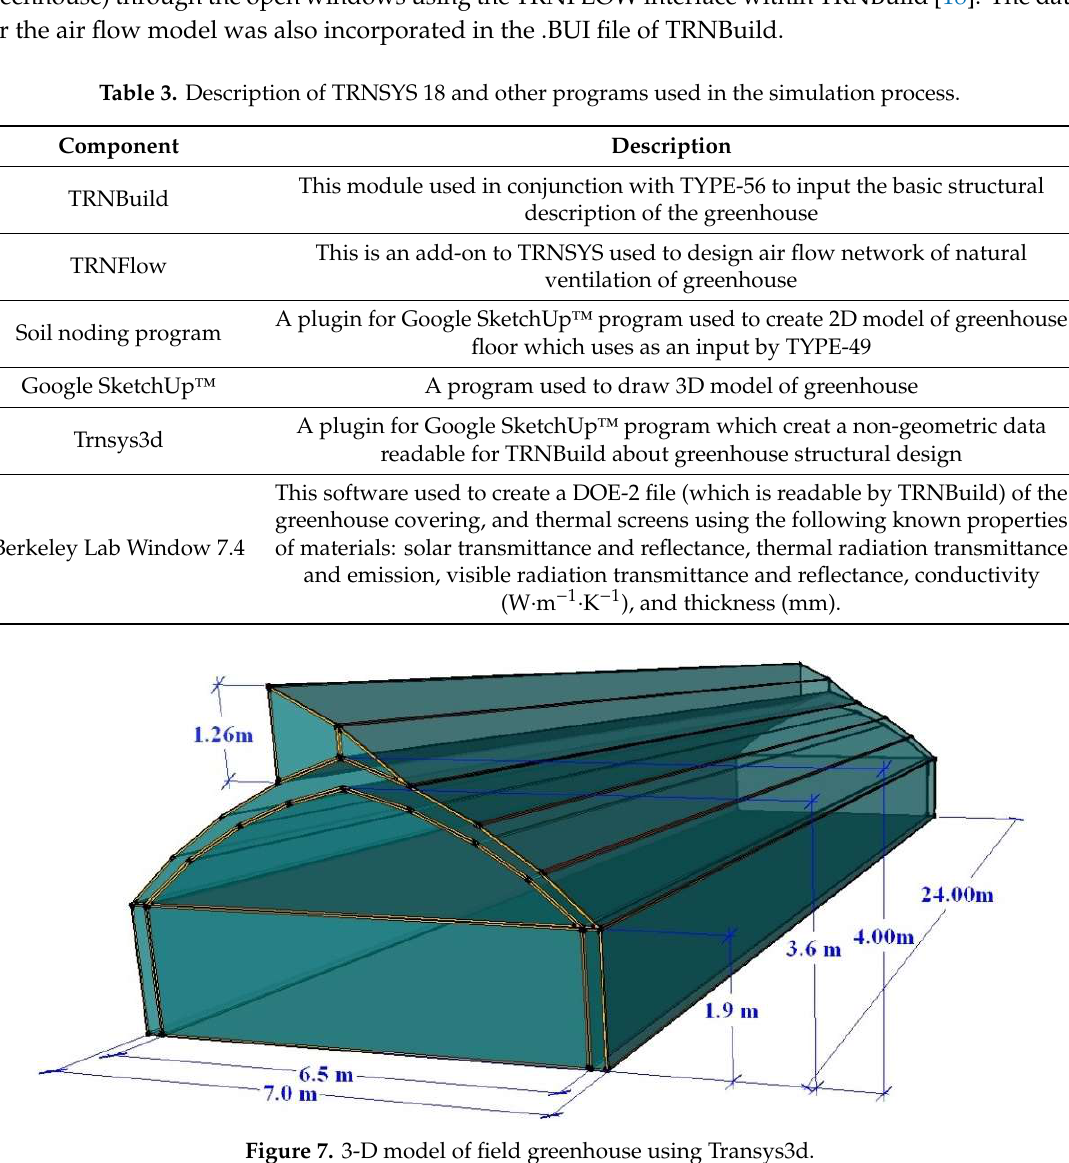
Figure 7. 3-D model of field greenhouse using